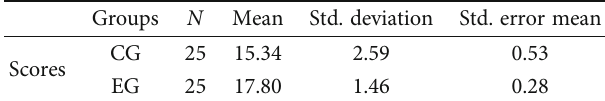
Table 3: Group statistics (posttest of both